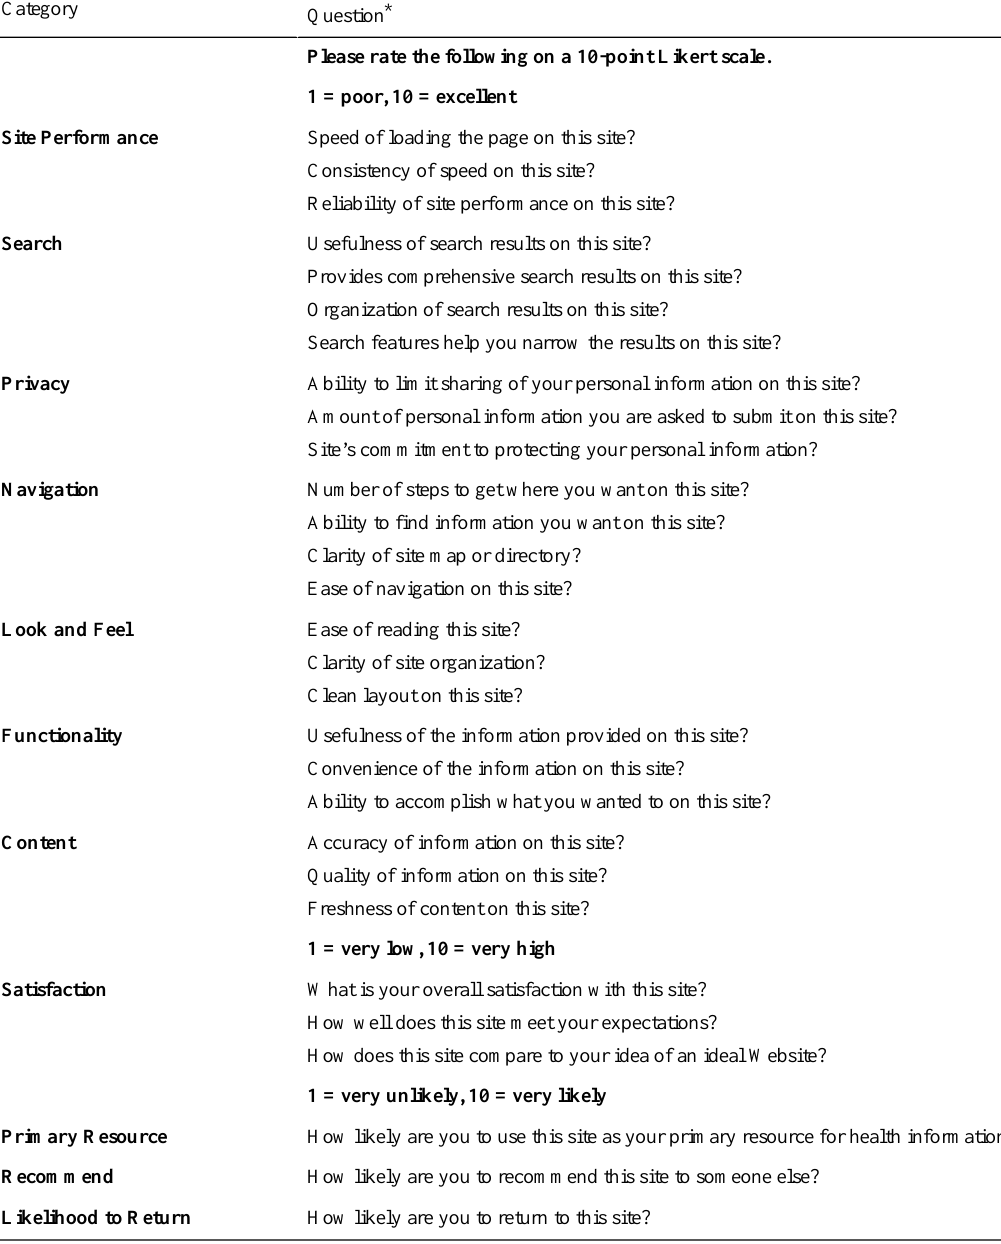
Table 2. Standardized questions used in the American Customer Satisfaction Index (ACSI) survey